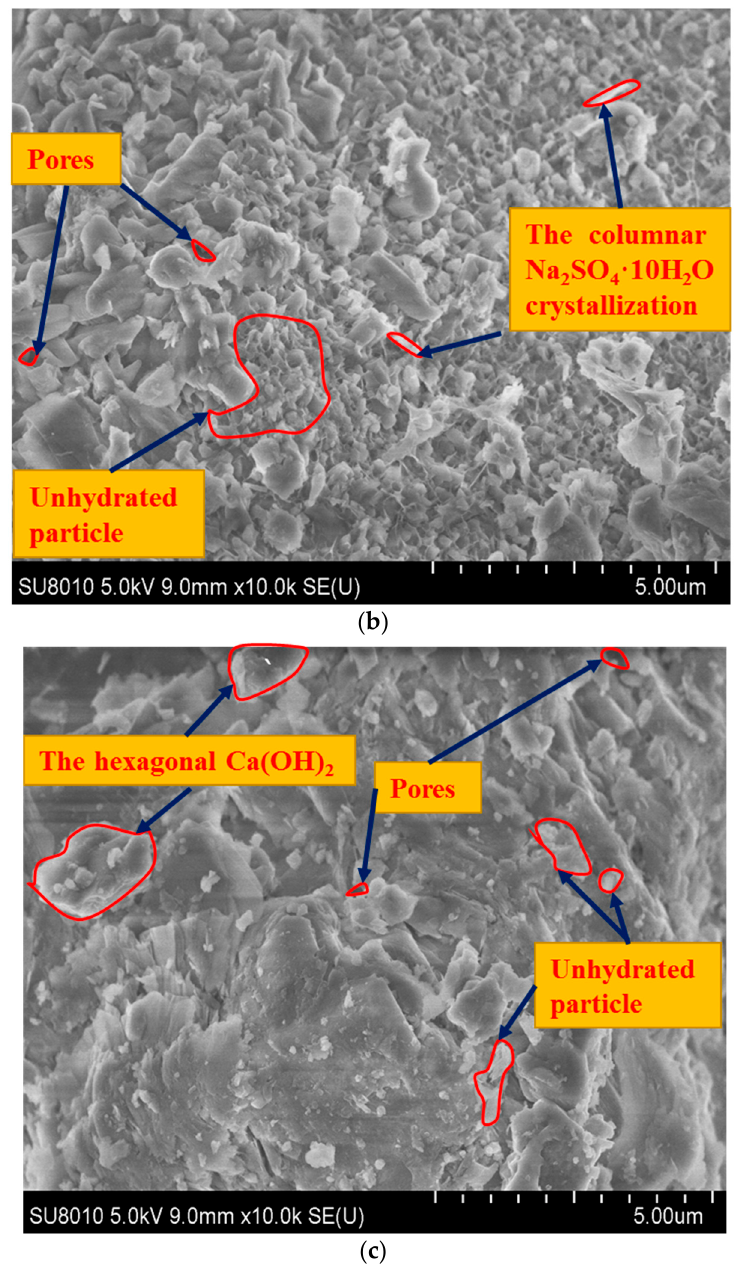
Figure 16. SEM images of specimens with different cement content. ( a ) Cement: 3%, sodium sulfate: 3%, temperature: 10 °C. ( b ) Cement: 4%, sodium sulfate: 3%, temperature: 10 °C. ( c ) Cement: 5%, sodium sulfate: 3%, temperature: 10 °C.